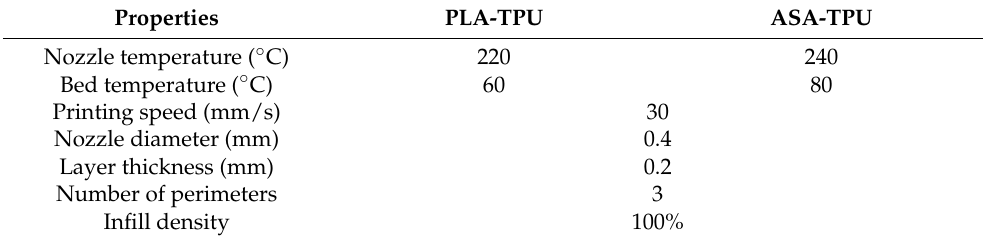
Table 2. Specimens process parameters.